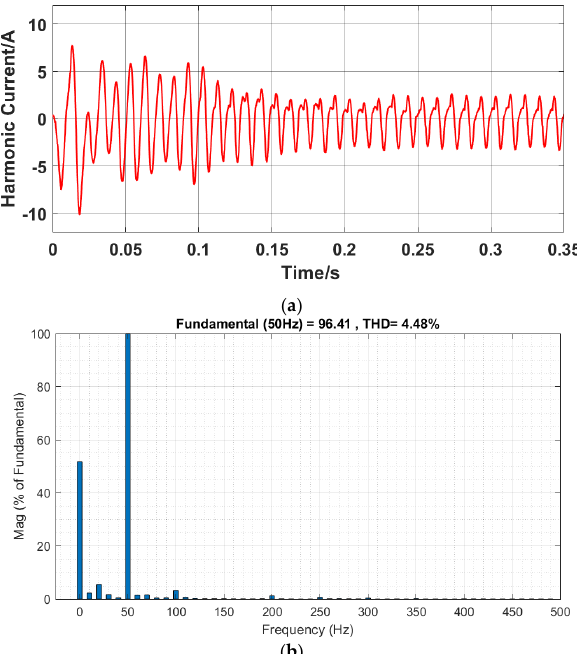
Figure 12. ( a ) Harmonic current with the PI control suppressor. ( b ) FFT analysis of the bridge arm current with the PI control suppressor. The case of using the QPR control circulating current suppressor is shown in Figure 13. The harmonic current component waveform is shown in Figure 13a, and the THD of the arm current was 4.48%, as shown in Figure 13b.